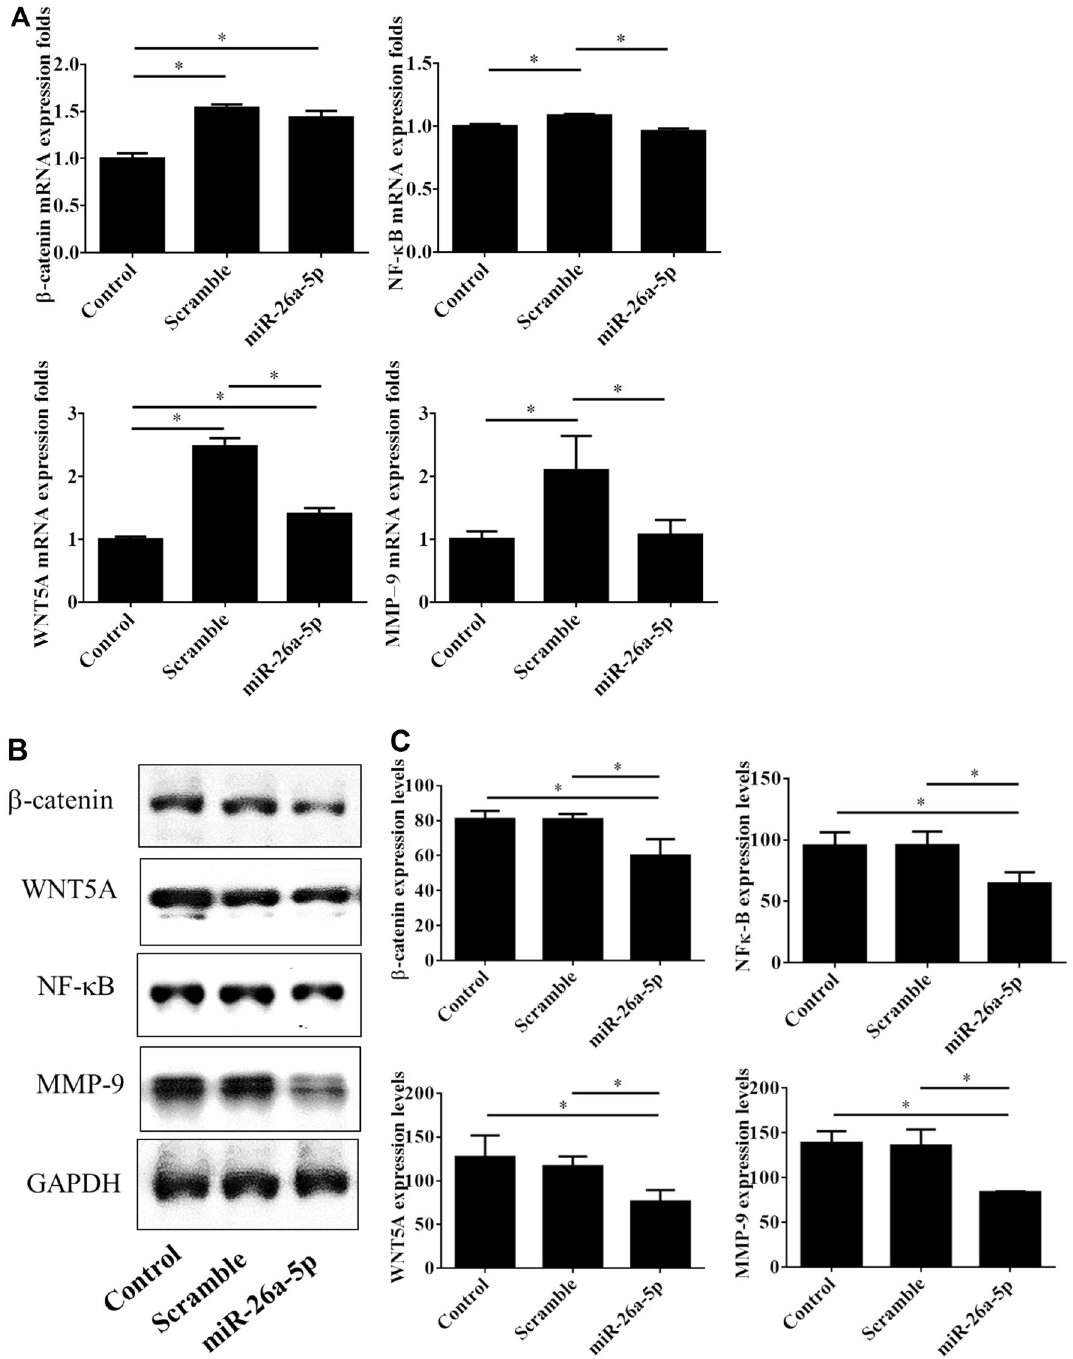
Figure 6. miR-26a-5p overexpression modulated expression of Wnt5A/β-catenin signaling mediators and downstream molecules in UTUC cells. BFTC-909 cells were transfected with miR-26a-5p mimics for 48 h and subjected to detection of mRNA and protein expression by using qPCR ( A ) and western blot ( B) , respectively. GAPDH was used as loading internal control. ( C ) The blotting densitometry of protein levels in BFTC-909 cells. Data are expressed as mean ± SEM (n = 3). *Indicates a P < 0.05 between the indicated